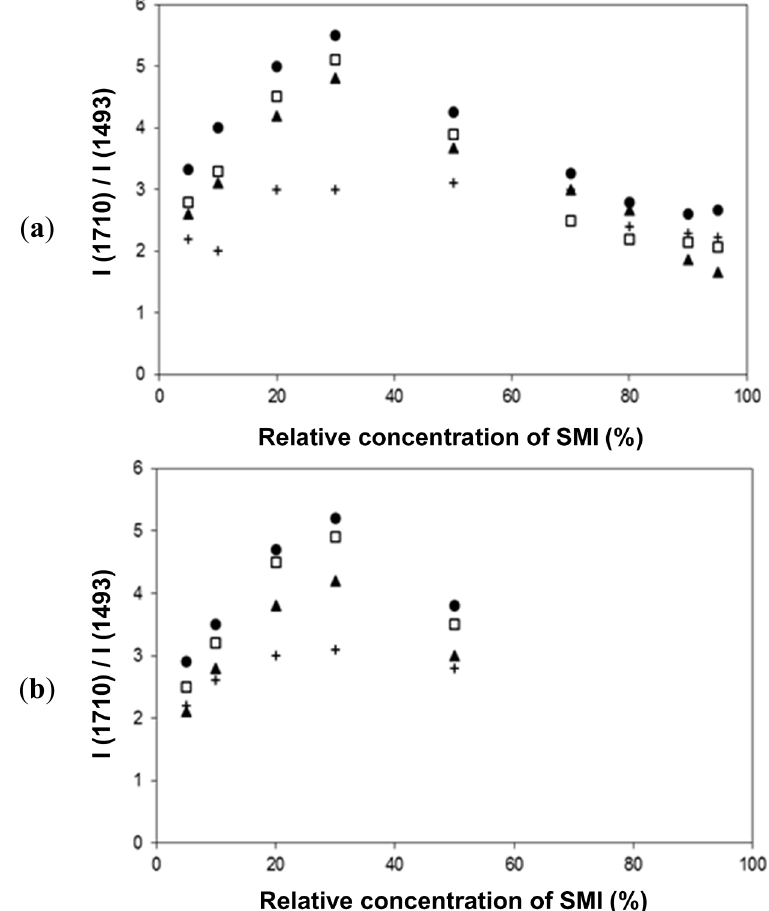
Figure 14. Thermal curing effects and quantification of band intensity ratios (imide/styrene) from FTIR spectra, ( a ) physically mixed Kln/SMI, ( b ) chemically reacted Kln/SMI: (+) non-annealed room temperature, ( ● ) 135 °C, ( □ ) 150 °C, ( ▲ ) 180